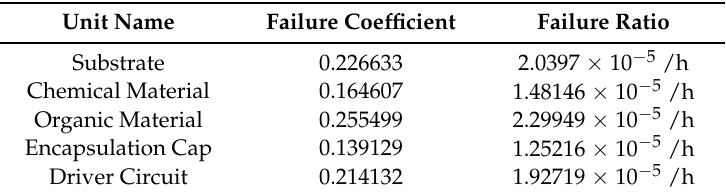
Table 1. Failure coefficient for each unit of the WOLED